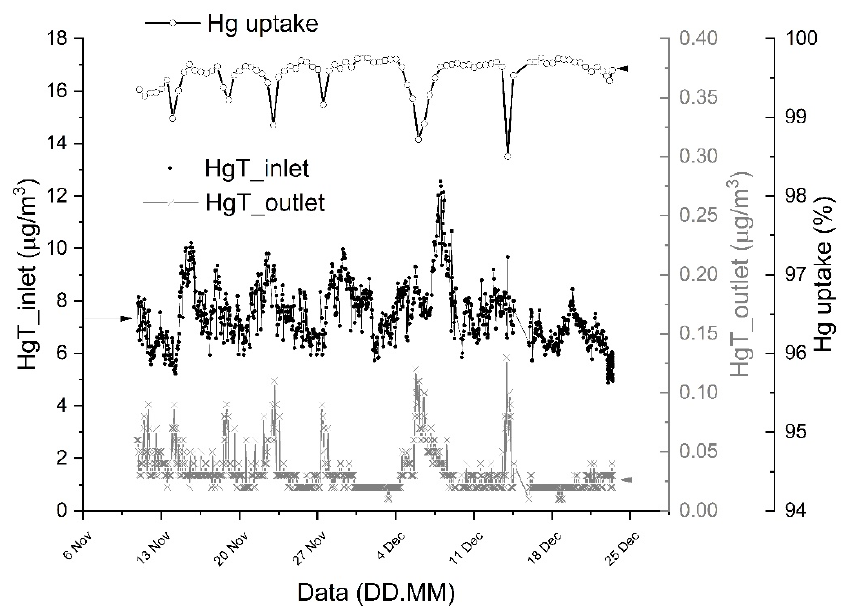
Figure 11. The content and capture of mercury in the flue gas at the inlet and outlet of a container with modules made of FSM during 42 days of industrial test.